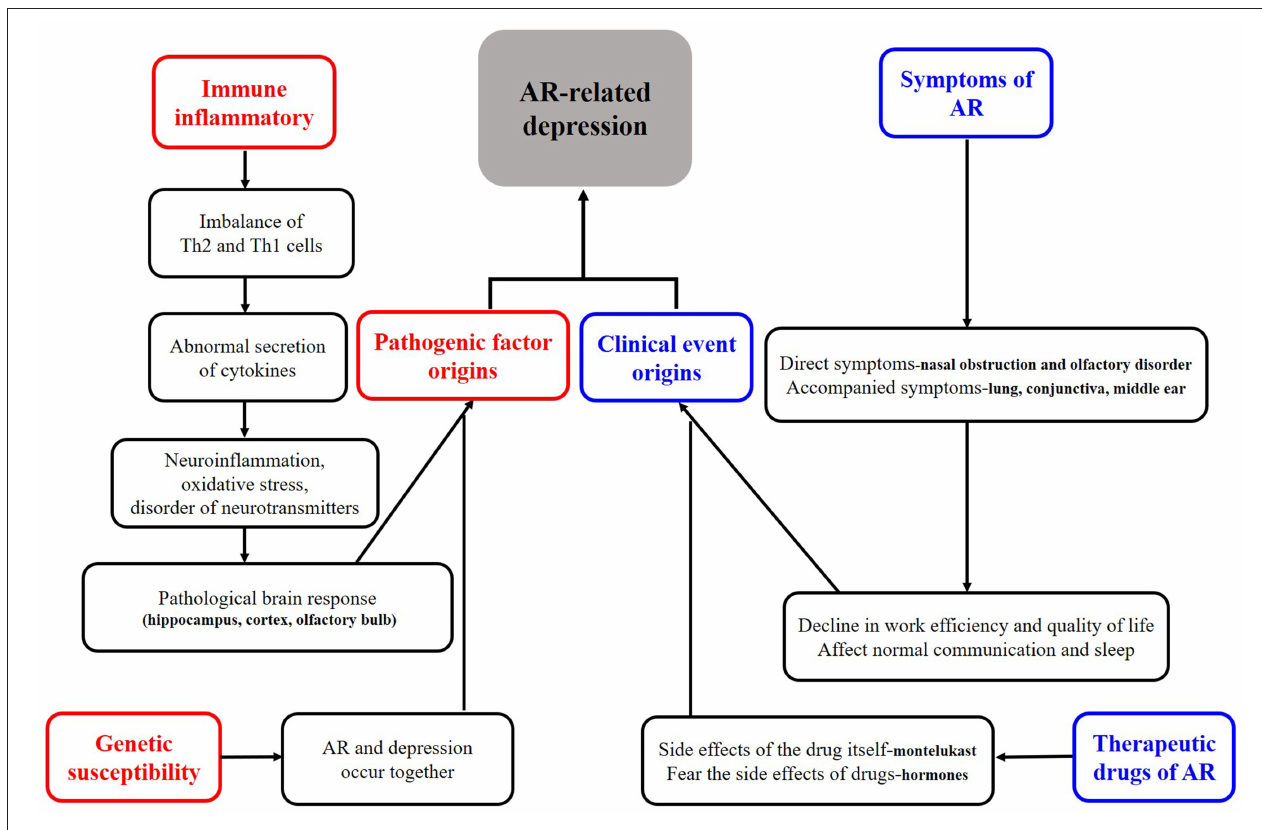
FIGURE 2 | Classification of depression in AR based on possible